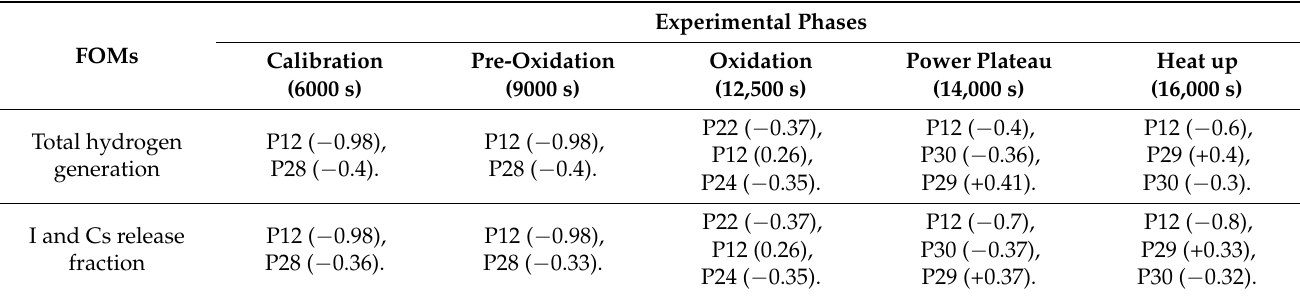
Table 3. Parameters with the biggest influence on the calculation results at the different experimental phases. Name of the parameter (influence